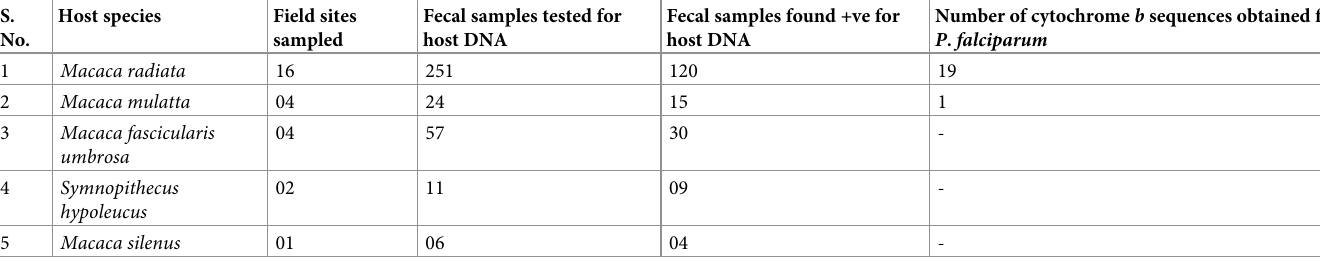
Number of cytochrome b sequences obtained